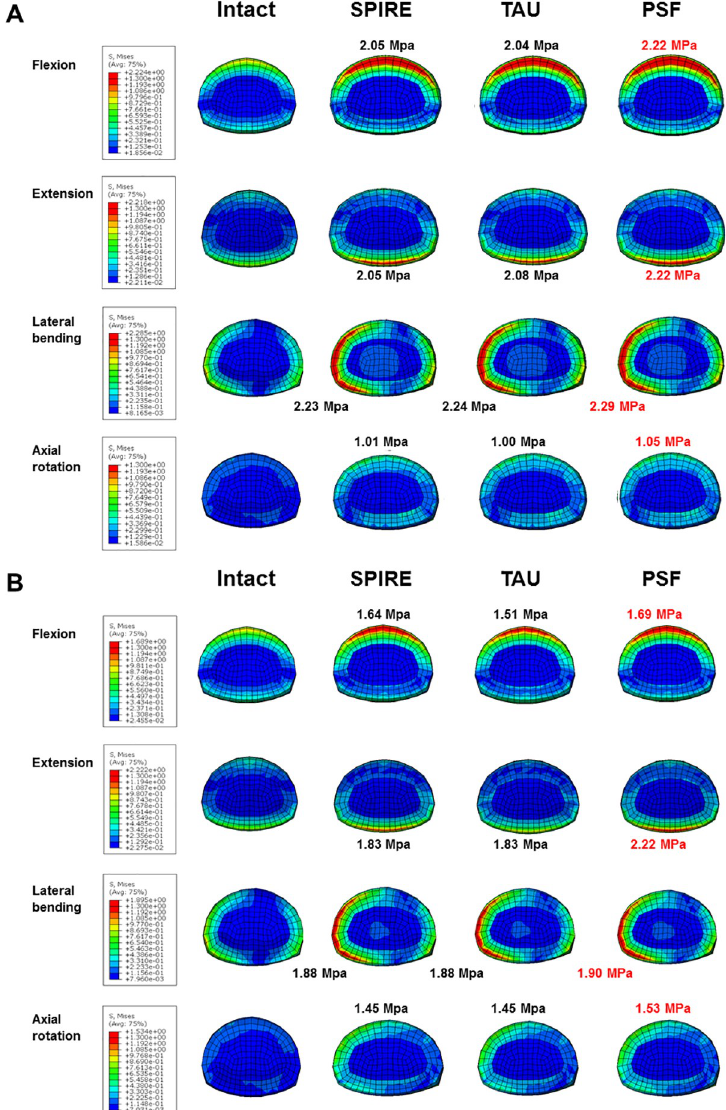
Fig 4. Stress distribution at the (A) superior (L2-L3) and (B) inferior (L4-L5) adjacent level